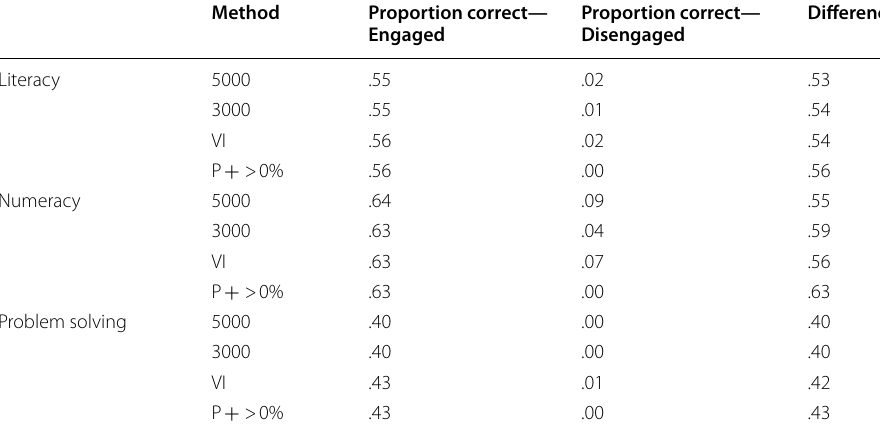
The table is from Goldhammer et al., (2016, p. 19)